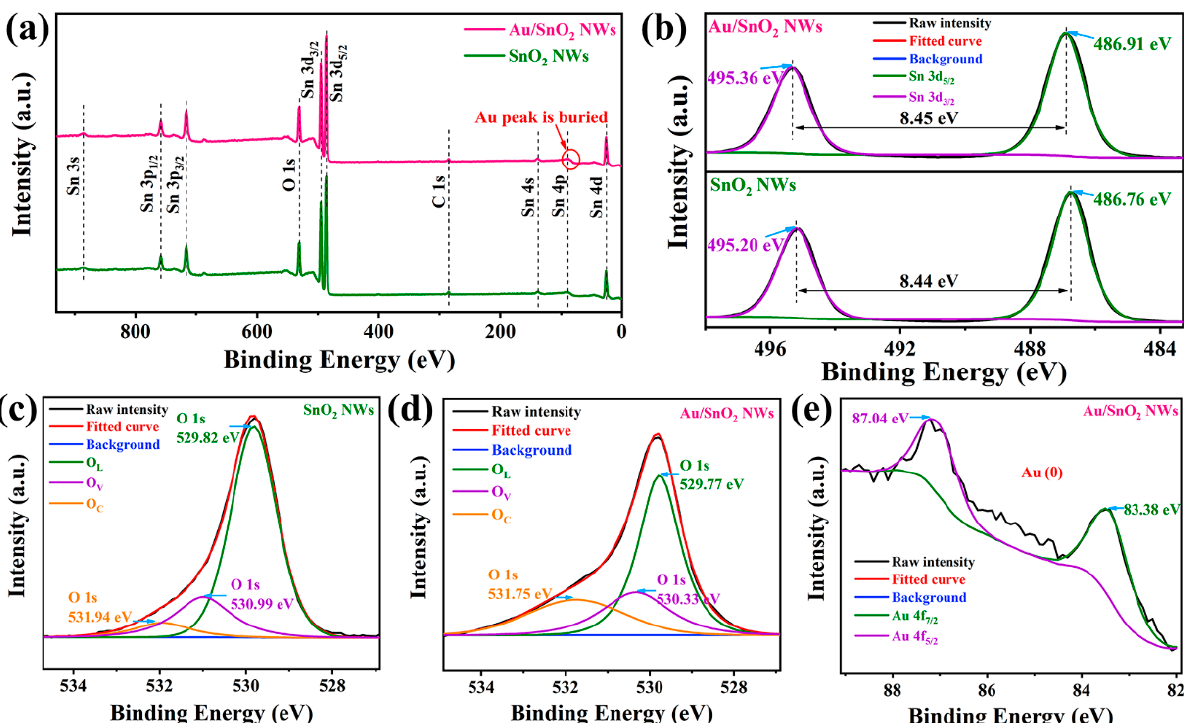
Figure 4. ( a ) Full-scan XPS spectra of SnO 2 and Au/SnO 2 NWs. ( b ) High-resolution Sn 3d spectra of SnO 2 and Au/SnO 2 NWs. Deconvoluted O 1s core-level spectra of ( c ) SnO 2 and ( d ) Au/SnO 2 NWs. ( e ) High-resolution Au 4f spectrum of Au/SnO 2 NWs.